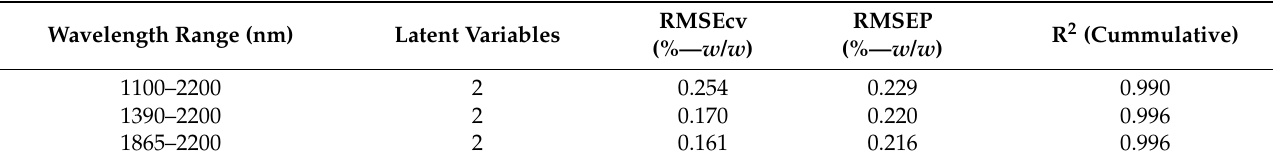
Table 2. Validation parameters of PLS calibration models.